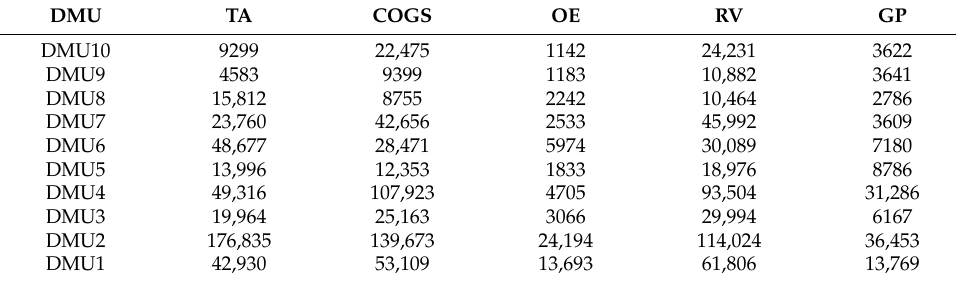
Table 3. Root mean square error of the decision-making units (DMUs).